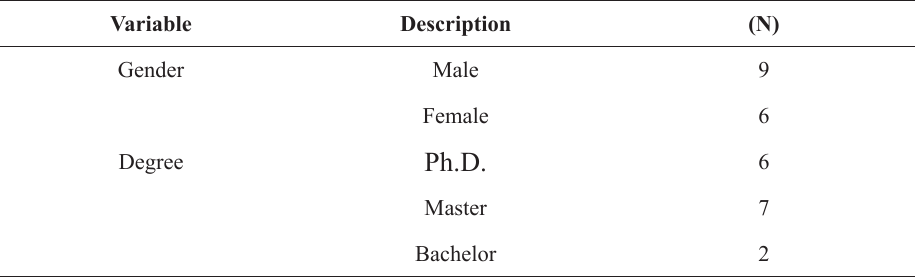
Table 3. Demographic profile of the qualitative sample (N = 15)